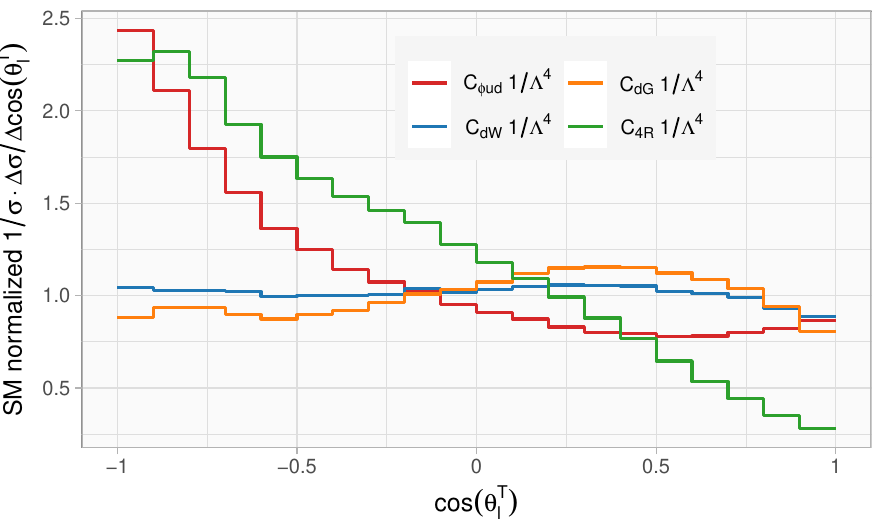
Figure 26. To itself and to the SM normalized SMEFT contributions to the cos (cid:18) T at NLO in QCD . Results are presented for Q 33 operator Q 4 R .